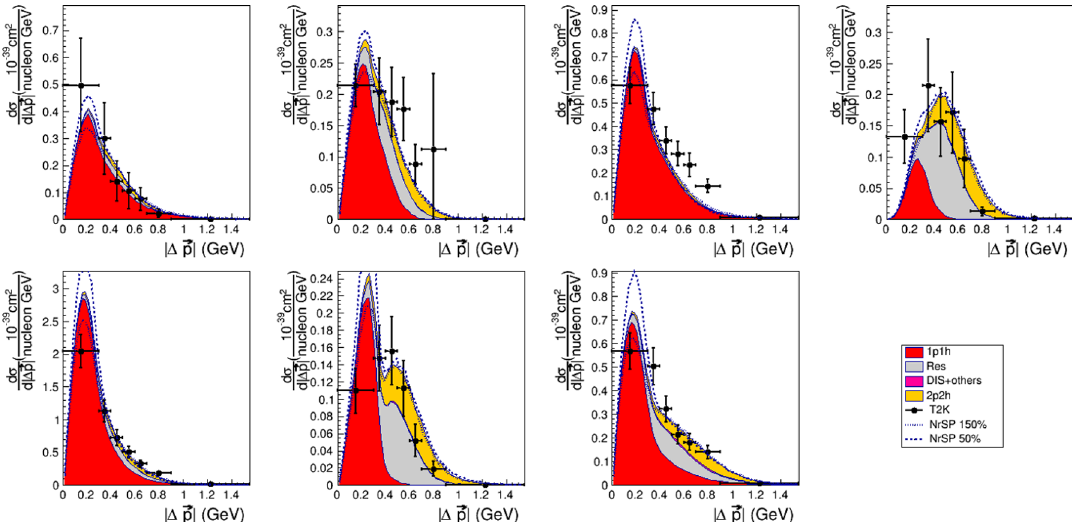
Figure 15 . T2K CC0 π 1p | ∆ ~p | distribution. The panels correspond to different muon kinematic bins. From left to right and up to down: − 1 < cos θ 0 . 6 , − 0 . 6 < cos θ 0 with | ~p µ < − µ < µ | < 250 MeV, − 0 . 6 < cos θ 0 with | ~p 250 MeV, 0 < cos θ 1 with | ~p 250 MeV, 0 < cos θ µ < µ | > µ < µ | < µ < 0 . 8 with | ~p 250 MeV, 0 . 8 < cos θ 1 with 250 MeV < | ~p 750 MeV and 0 . 8 < cos θ 1 µ | > µ < µ | < µ < with | ~p 750 MeV. Data taken from ref. µ | >